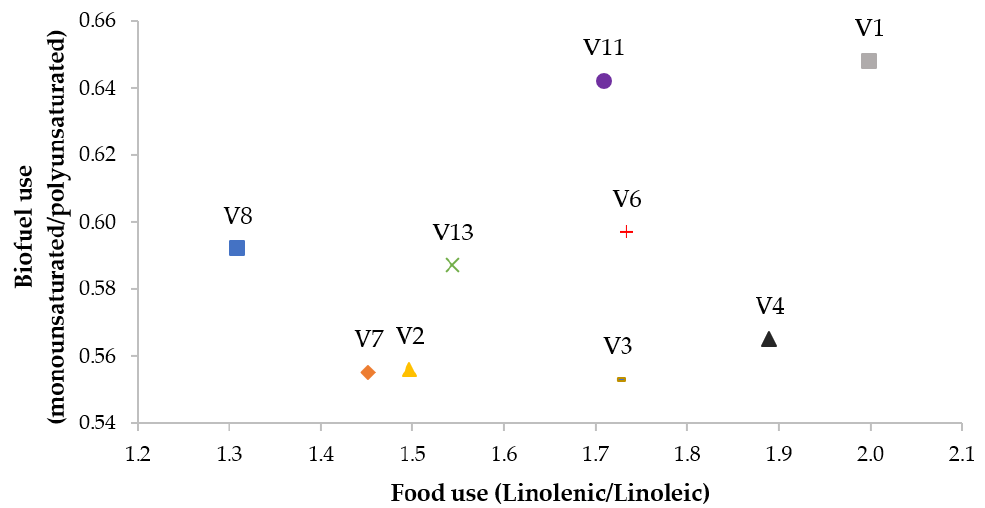
Figure 3. Presentation of nine varieties of Camelina sativa reflecting their potential use for food (linolenic/linoleic acid) and biofuel (monounsaturated fatty acids/ polyunsaturated fatty acids). Our results indicate that some varieties of camelina can be used for food purposes Comparing the oil content and fatty acids composition of Camelina sativa seeds with (Figure 3). Regarding this potential food use, camelina oil should have a balanced linolenic/ other oil crops, we can infer that camelina is a better option for food use. In comparison with linoleic acid ratio and a saturated fatty acid content below 10% [57,58]. Also, in other crops, such as palm, kernel, soybean, sunflower, or canola (Table 3), it has the highest content of linolenic acid and a higher percentage of linoleic than canola. Regarding saturated fatty acids (Table 3), camelina oilseed has the lowest content in this kind of acids together with the sunflower. The oilseed of LEAR canola oil has a fatty acids profile similar to C. sativa, but the erucic acid content, considered a limiting factor for human consumption, in the oil of C. sativa ranged from 2.68% to 3.17%, while in the LEAR canola is less than 2% [64]. Nevertheless, this makes camelina a potential option for human consumption. Table 3. Typical fatty acid composition in major oil crops and camelina (%). a Palm